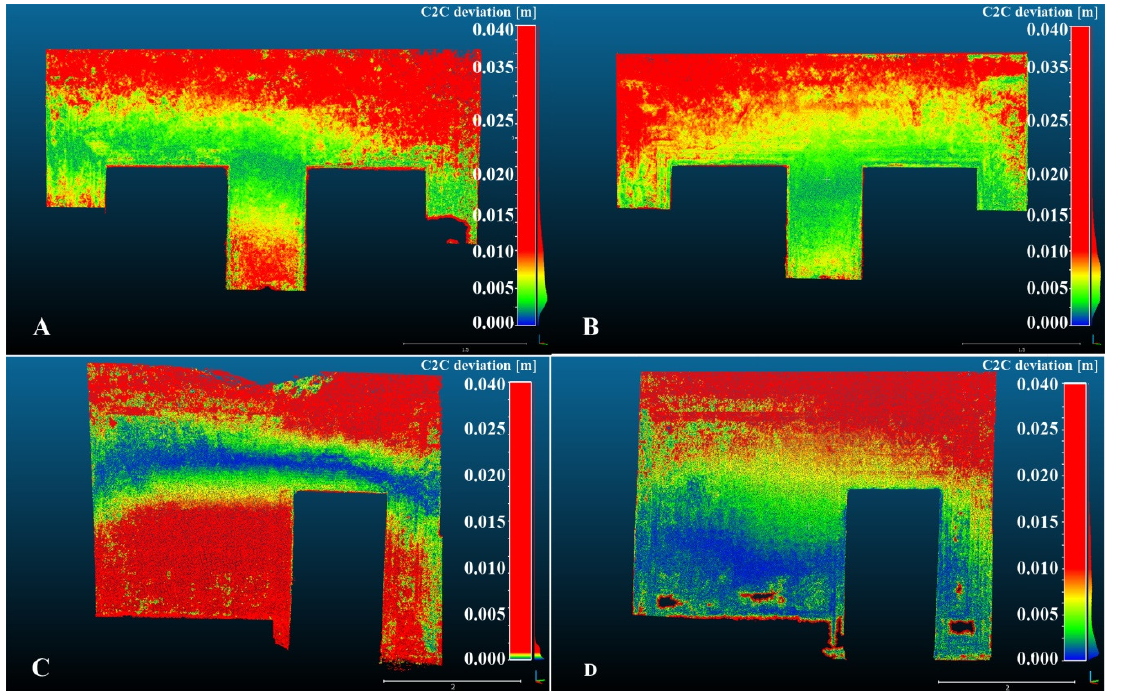
Figure 13. Map of differences between points from a reference point cloud a) Canon - Xiaomi Yi 2k (Wall II), b) Canon - Xiaomi